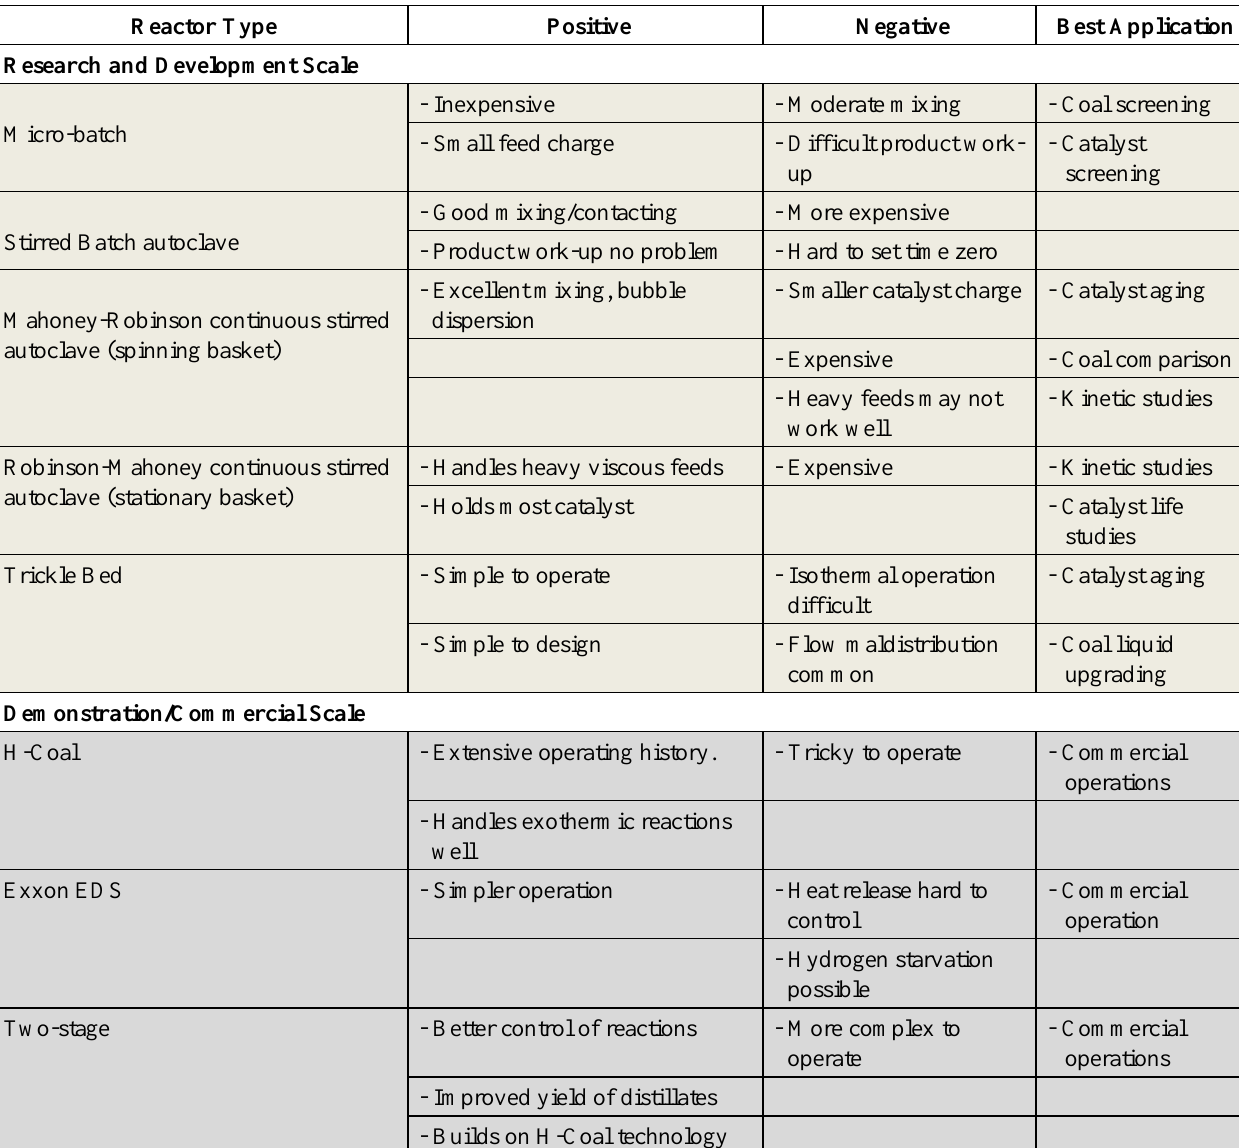
Table 7. Liquefaction reactor